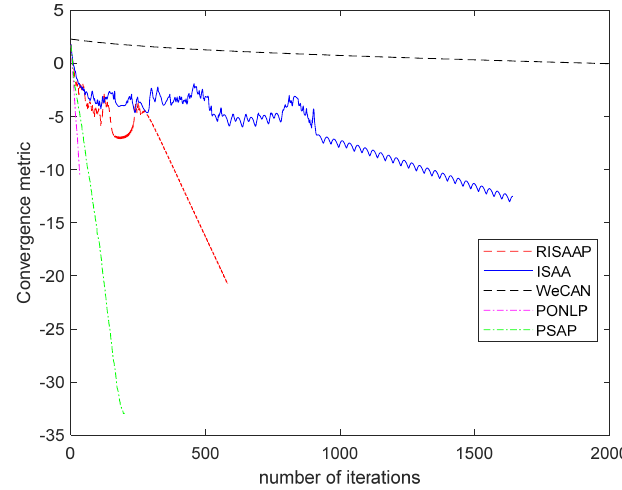
Figure 2. Convergence comparison of different methods.